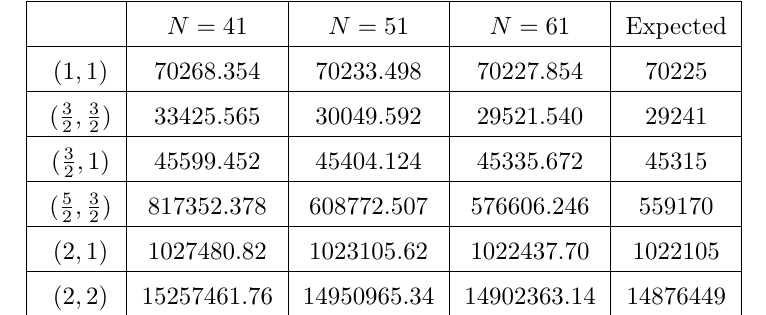
. The results include scalar 2 SCFT(right). 2